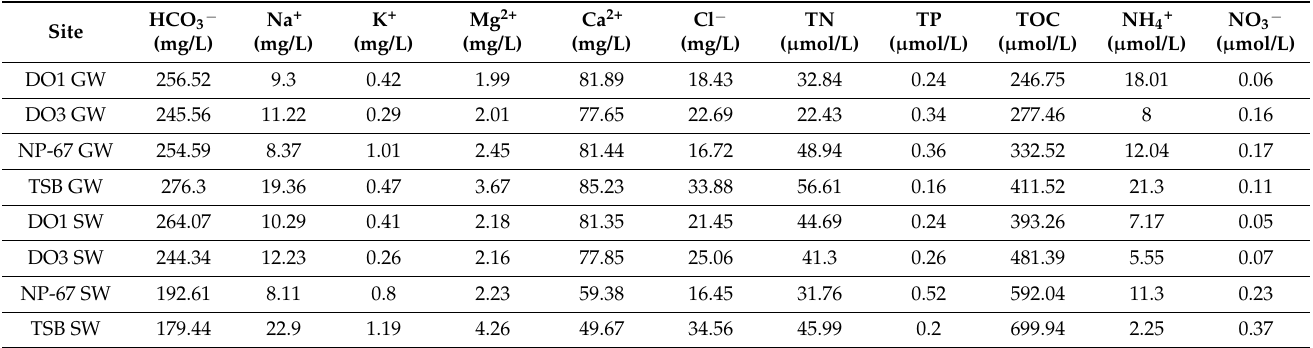
Table 2. Average concentrations of major ions and nutrients for groundwater (GW) and surface-water (SW) samples